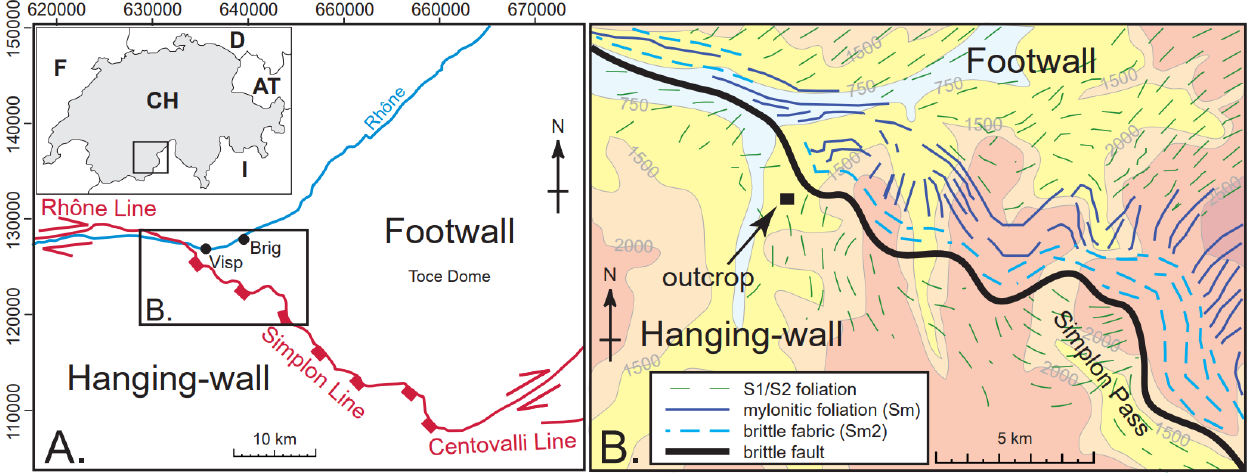
Figure 1. Geological overview: ( A ) Major parts of the Simplon Fault Zone and its location in southern Switzerland and northern Italy. Box shows the area in ( B ) Close-up of the Visp area, showing the outcrop location, the orientation of the brittle fault and ductile fabrics of the SFZ, and foliation in the footwall and hanging-wall (after Campani et al. 2010 [36]), underlain by topography, contours at 500 m.